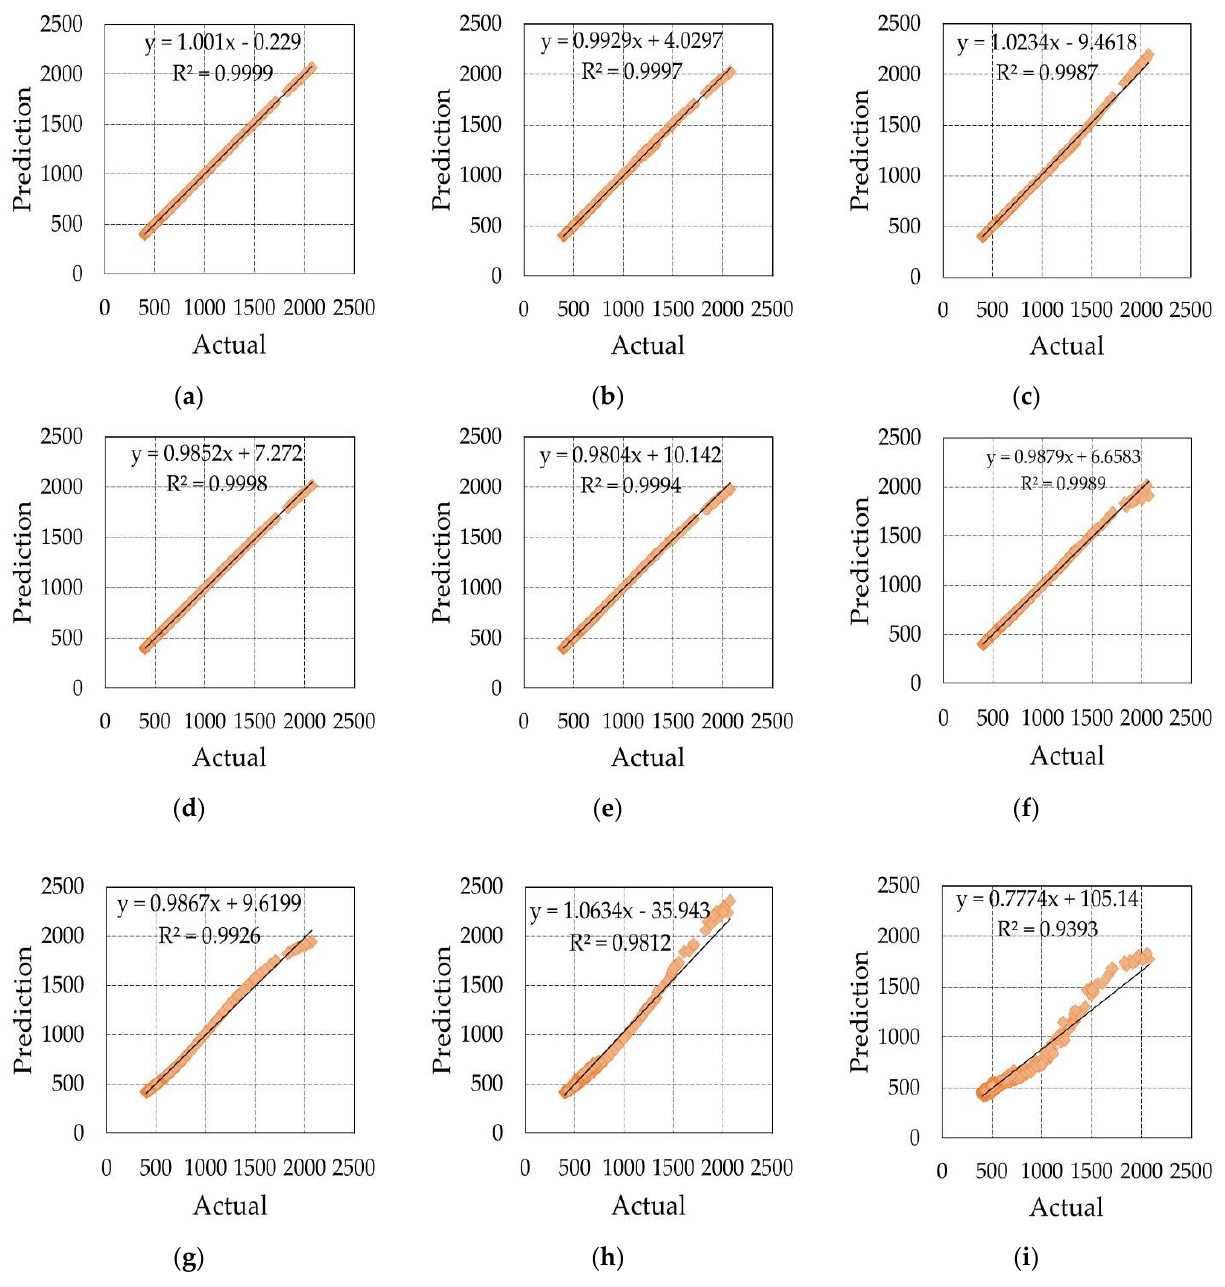
Figure 4. R 2 of prediction results of CO 2 concentration. ( a ) LM-Hidden layer-1; ( b ) LM-Hidden layer-3; ( c ) LM-Hidden layer-5; ( d ) BR-Hidden layer-1; ( e ) BR-Hidden layer-3; ( f ) BR-Hidden layer-5; ( g ) BFG-Hidden layer-1; ( h ) BFG-Hidden layer-3; ( i ) BFG-Hidden layer-5.